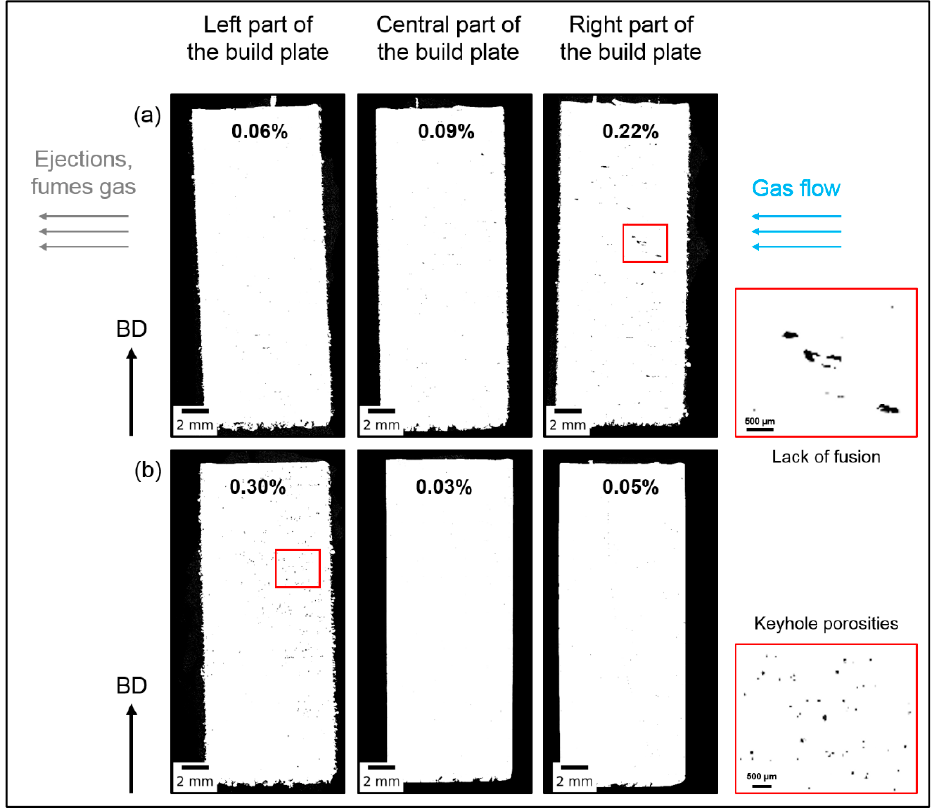
Figure 5. Analysis of porosity (indicated in vol%) on cross-sections using optical microscopy for the L-PBF-3 ( a ) and L-PBF-1 ( b ) conditions at three different locations (left, center, and right) on the building platform.